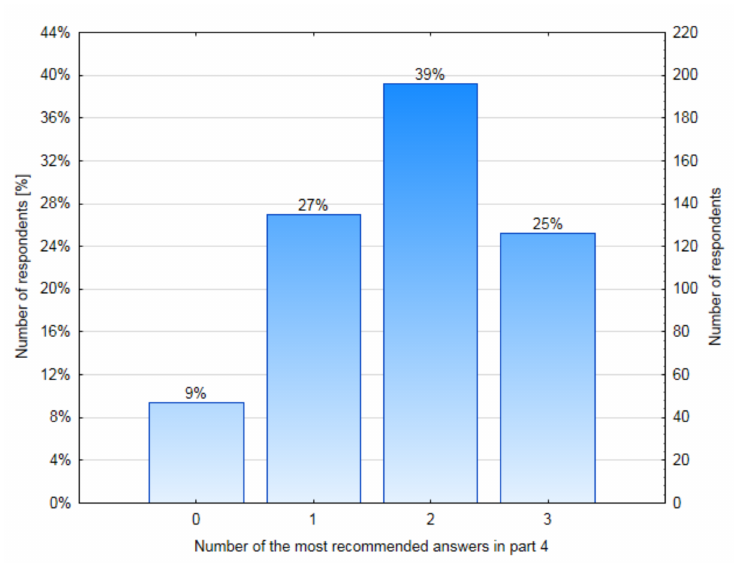
Figure 3. The number of the most recommended answers in part 4 of the